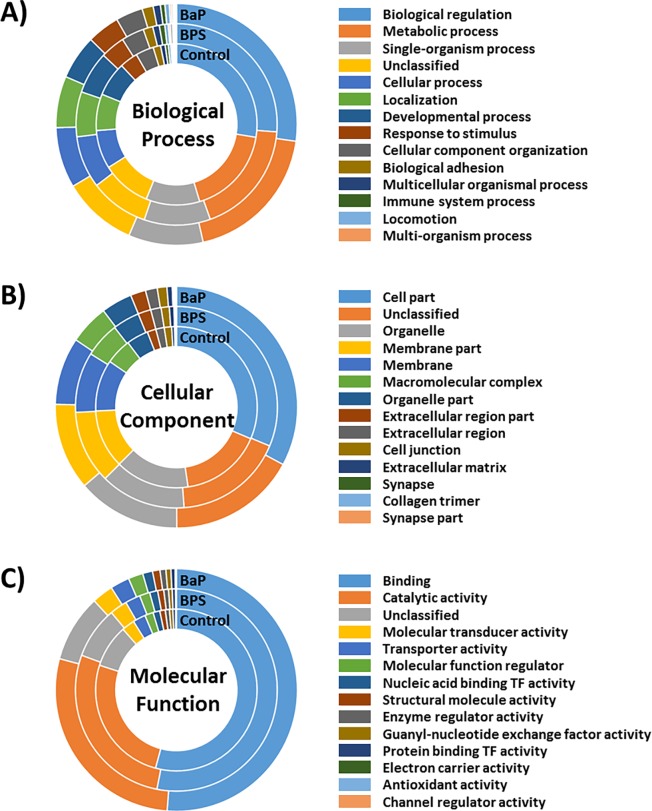
Functional classification of differentially expressed genes.Comparison of Gene Ontology (GO) in terms of (A) biological process, (B) cellular components, and (C) molecular function that were enriched in the BPS- or BaP-exposed liver tissues of P. olivaceus. Composition of each GO term is represented as a percentage. For detailed information see in S3 Table.